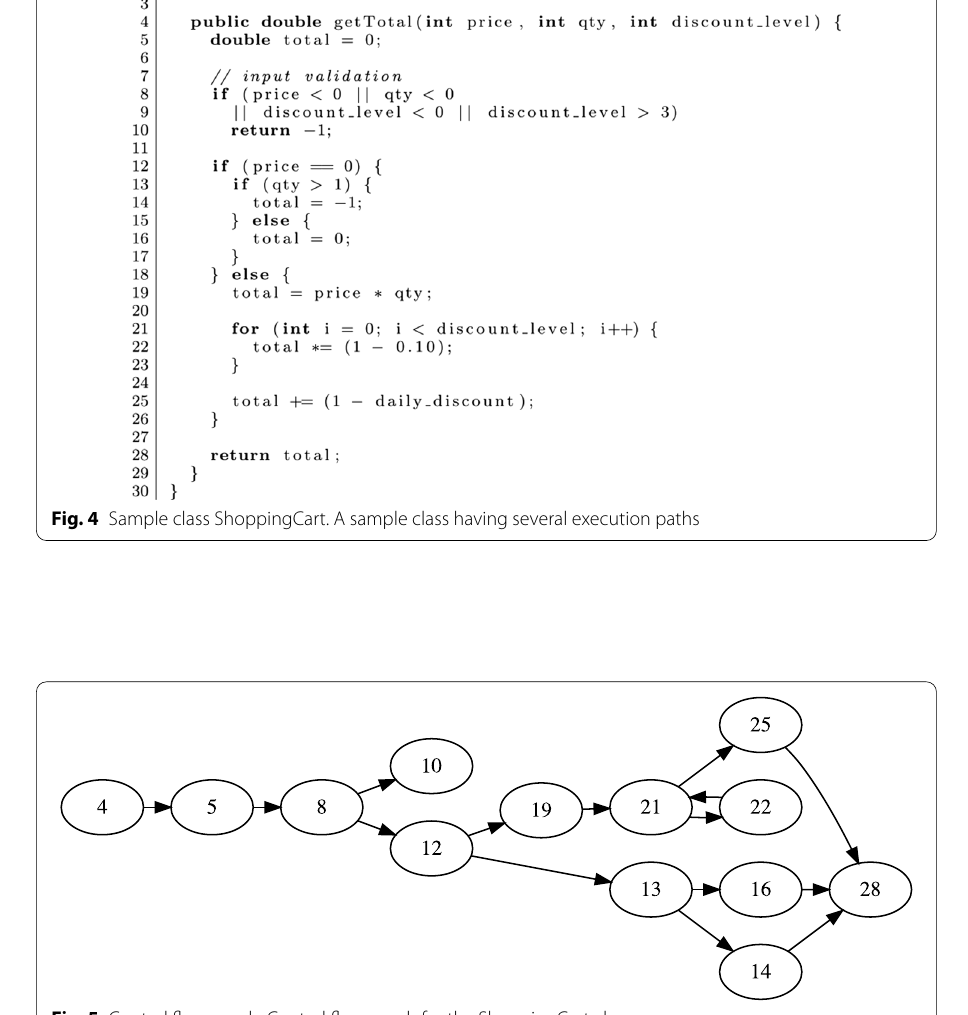
Fig. 5 Control flow graph. Control flow graph for the ShoppingCart